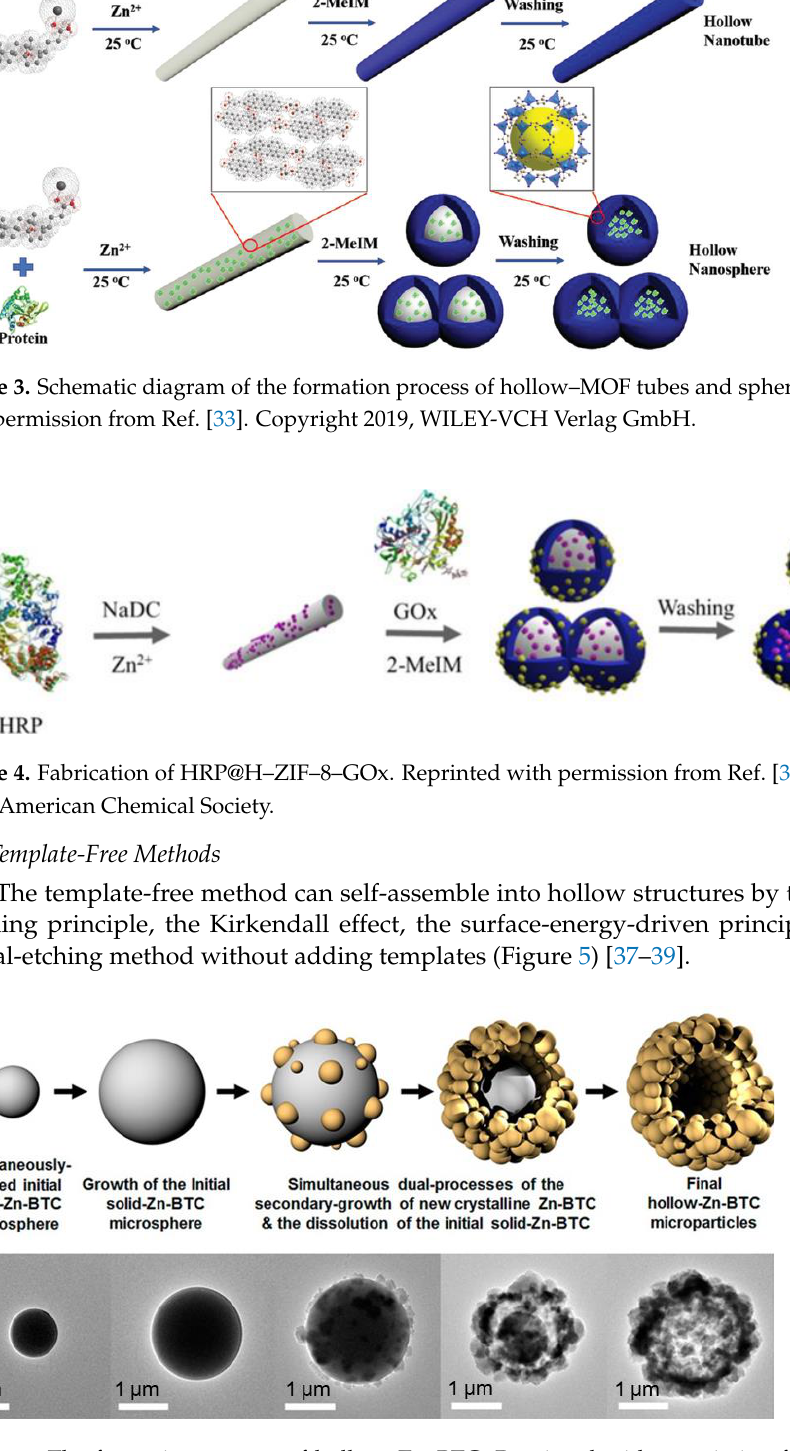
Figure 3. Schematic diagram of the formation process of hollow – MOF tubes and spheres. Re- printed with permission from Ref. [33]. Copyright 2019, WILEY-VCH Verlag GmbH.